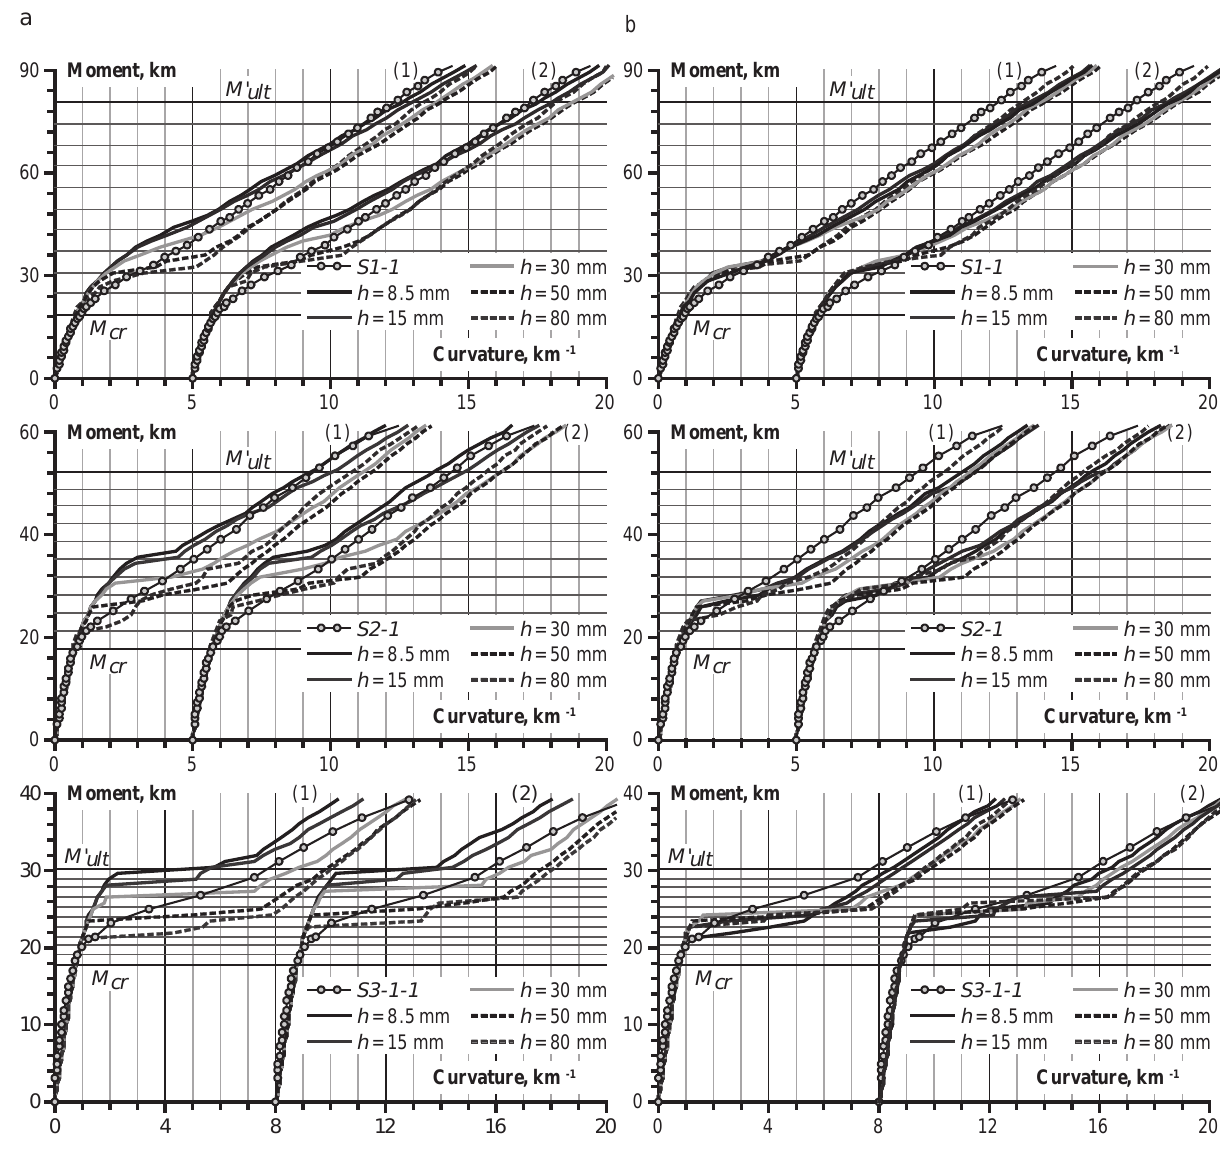
Fig. 4. Moment-curvature diagrams of experimental beams calculated using stress-crack width (1) and average stress-average strain (2) relationships